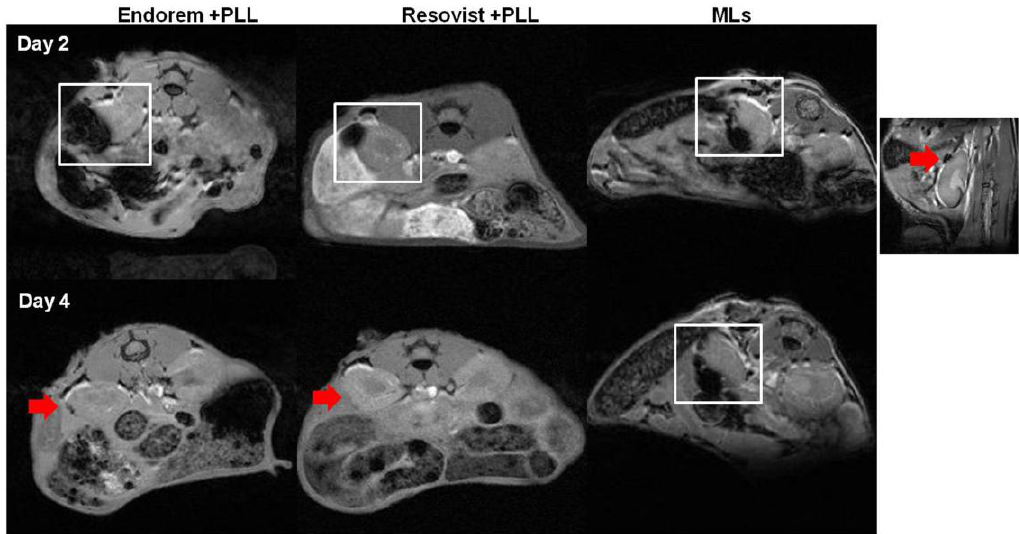
Figure 6. MR imaging of transplanted islets: MR imaging was performed to detect the labeled islets in vivo. The hypointense sub-capsular region (highlighted by white square) indicates PIs labeled with Endorem + PLL and Resovist + PLL. Endorem or Resovist + PLL-labeled islets were not detectable on day four in the sub-capsular region (red arrows), whereas PIs labeled with MLs were detectable until day four (indicated by white square). The right corner image indicates a prominent black spot (red arrow) seen on the sub-capsular region after transplantation of PIs labeled with MLs.